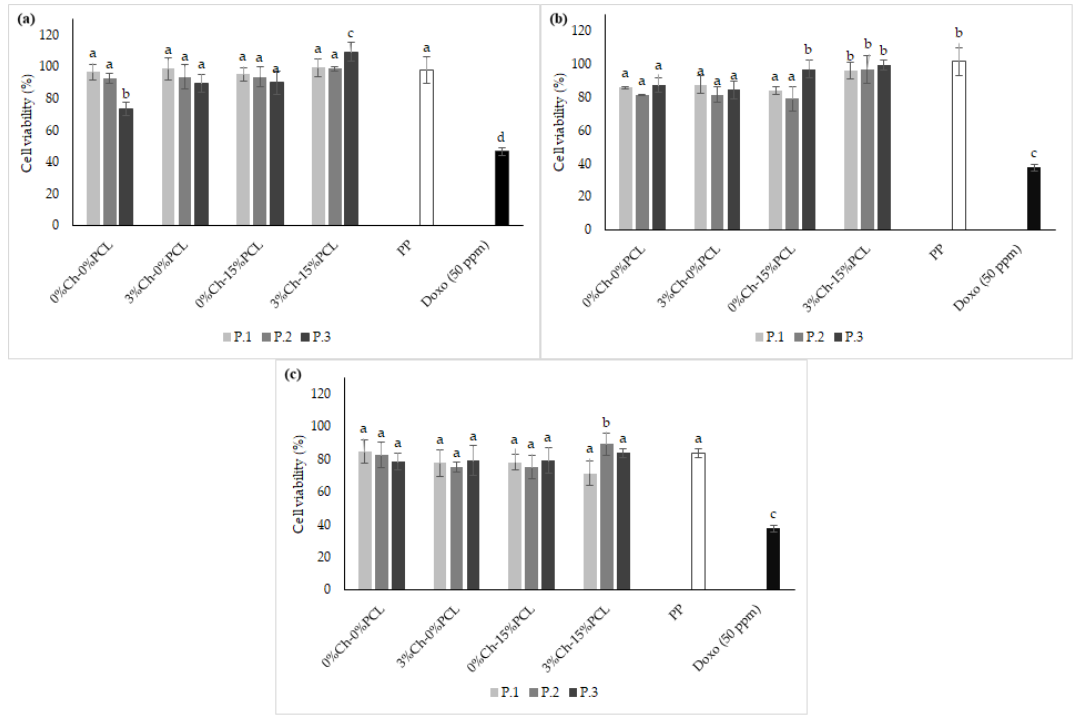
Figure 12. Percentage of cell viability at 24 h. ( a ) L929 Mouse fibroblasts; ( b ) Human fibroblasts (MRC-5); ( c ) Human dermal fibroblasts (HDFa). The data are expressed as the mean ± SD (n = 3). Bars with different letters (a–d) indicate significant differences ( p < 0.05) between the polyols.